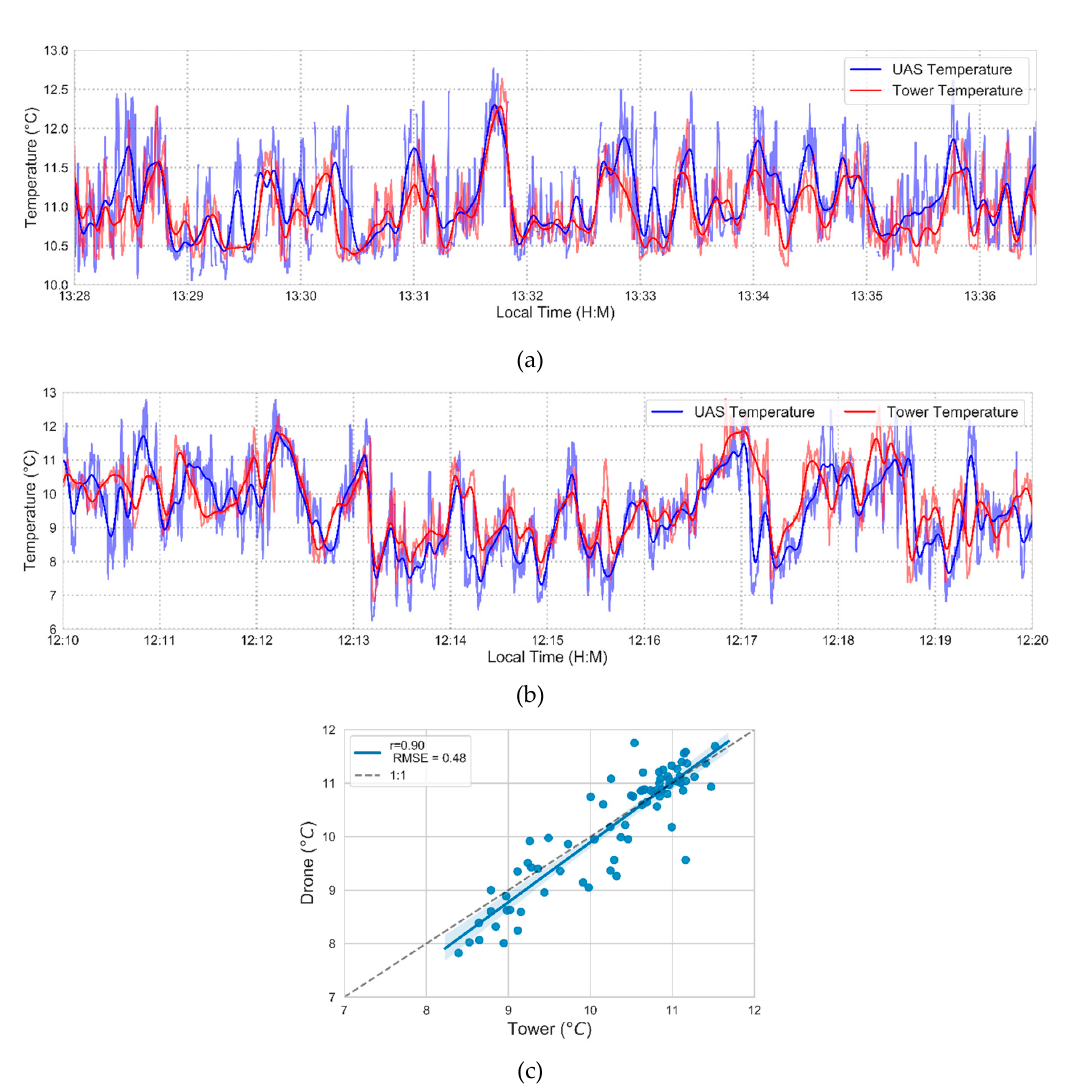
Figure 6. ( a ) Flight 1 time series of RMY and UAS sonic temperature in red and blue, respectively. Bold lines represent 15 s moving average with semi-transparent representing 1 s moving average. ( b ) Flight 2 time series of RMY and UAS sonic temperature in red and blue respectively, with time averaging noted above. ( c ) Scatter plot of UAS sonic temperature versus RMY wind speeds for both flights in blue dots. Linear regression and 95% confidence interval in blue line and shading.